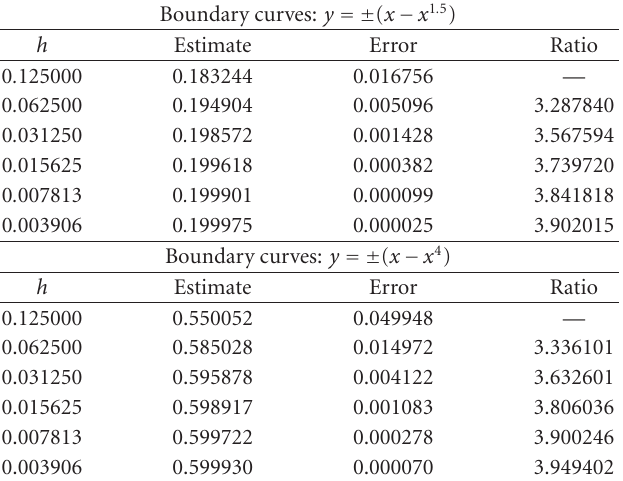
Table 3.4. Boundary approximation when r =